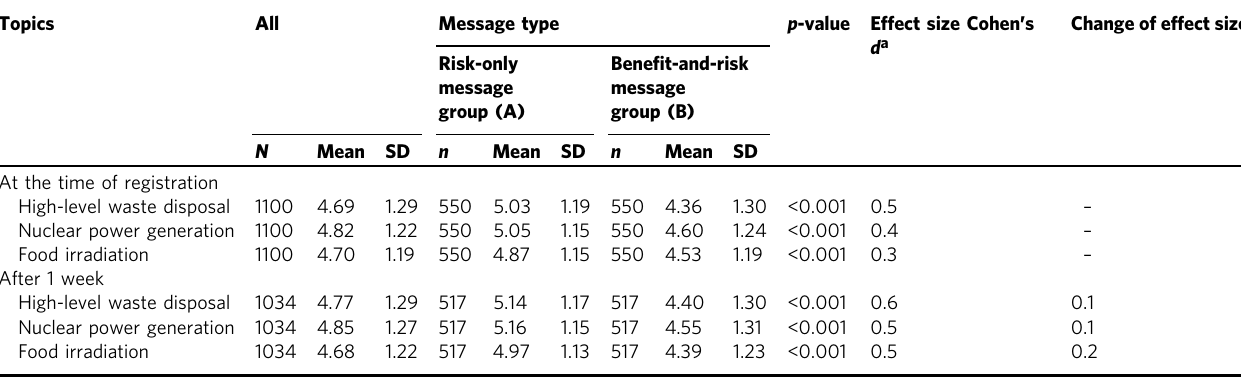
Table 2 Differences of trust level in public agency between rink and bene fi t-risk message groups. Topics